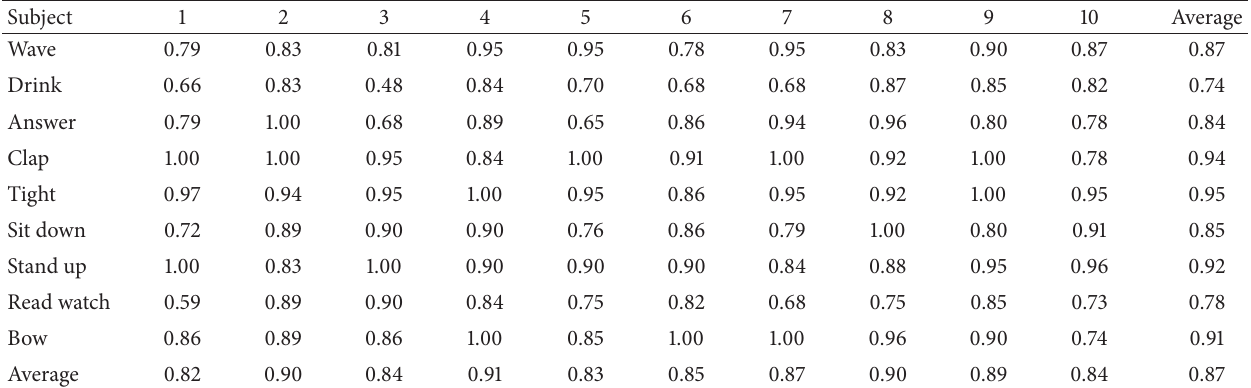
Table 6: Results on Florence 3D Actions dataset.